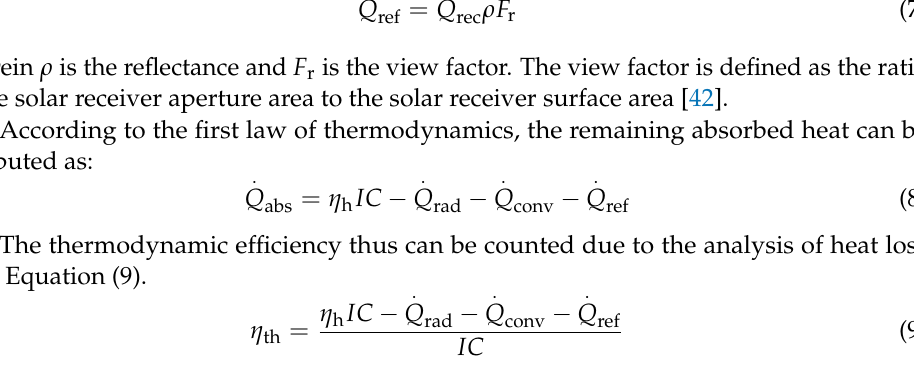
Table 1. Properties and values for the integrated